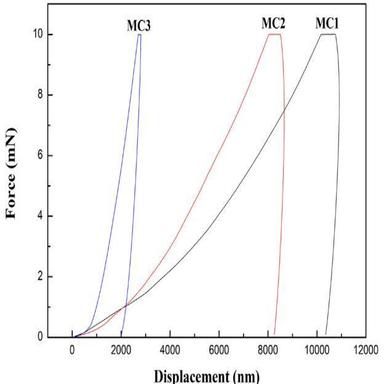
Force-displacement curves of different microcapsules.